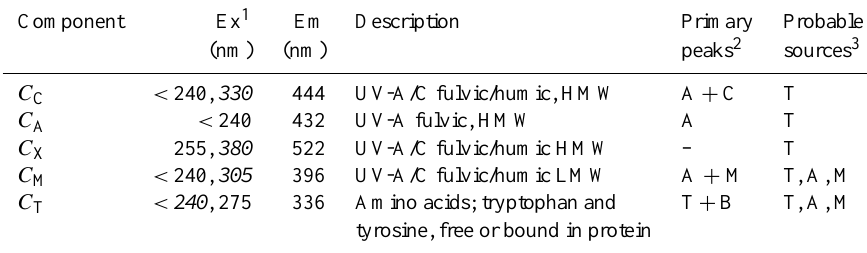
Table 2. Description of DOC fluorescence components identified by PARAFAC